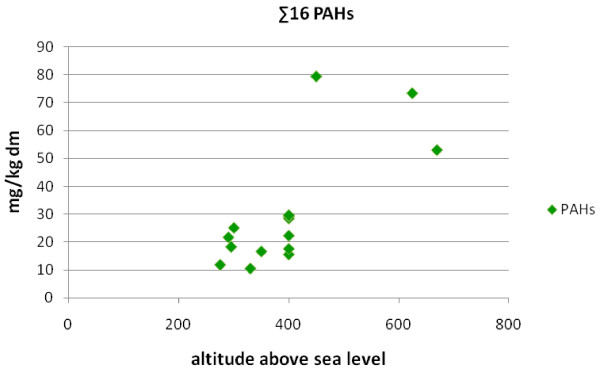
The total PAH concentration as a function of altitude.